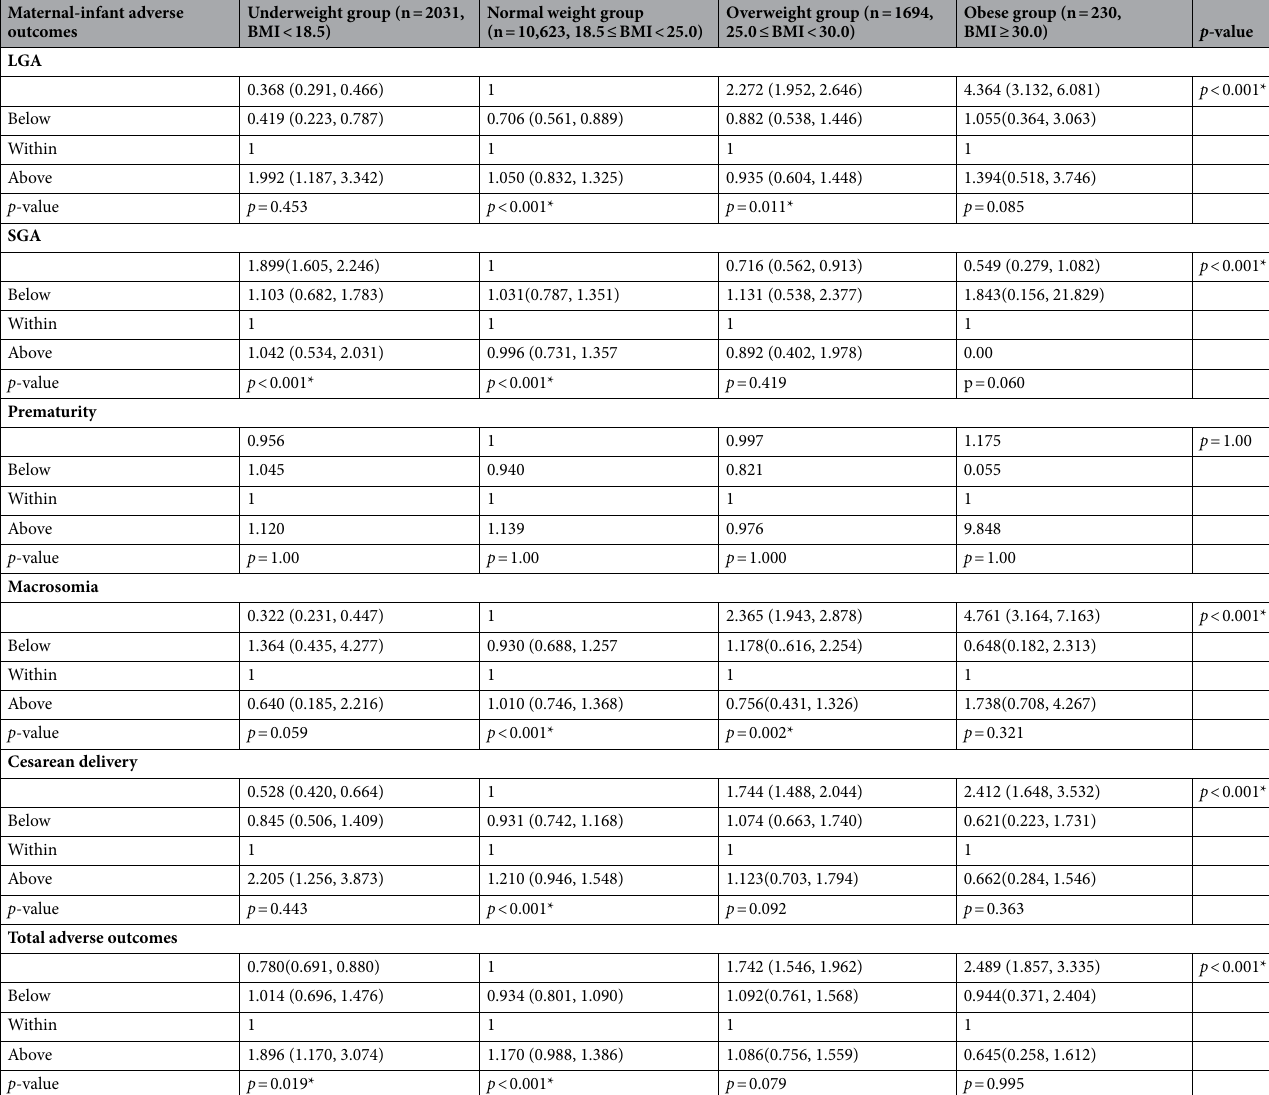
Table 4. The odd ratios (95% confidence intervals) of maternal-infant adverse outcomes by joint effects of maternal prepregnancy body mass index and gestational weight gain. BMI body mass index, GWG Gestational weight